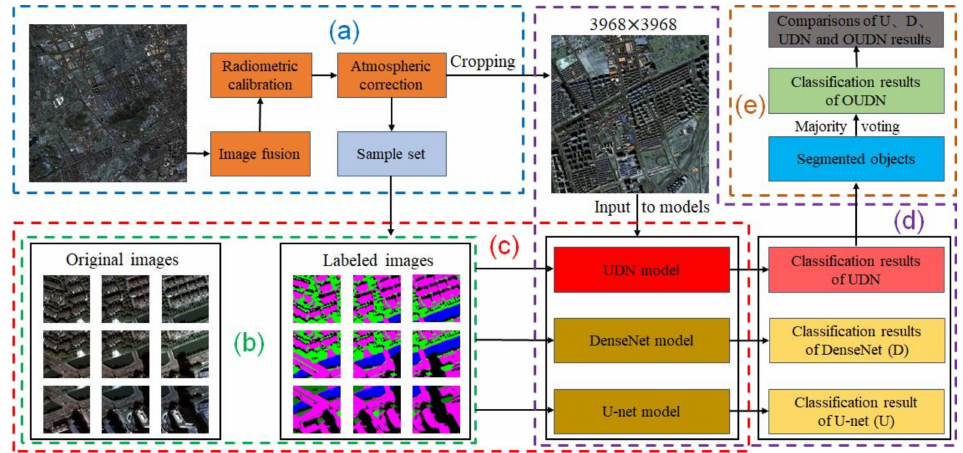
Figure 7. A flowchart of the experimental method in this paper, including five major steps: ( a ) image preprocessing; ( b ) image labeling and image cropping; ( c ) model training; ( d ) model prediction; ( e ) object-based optimization of the UDN results and comparisons of the results from all